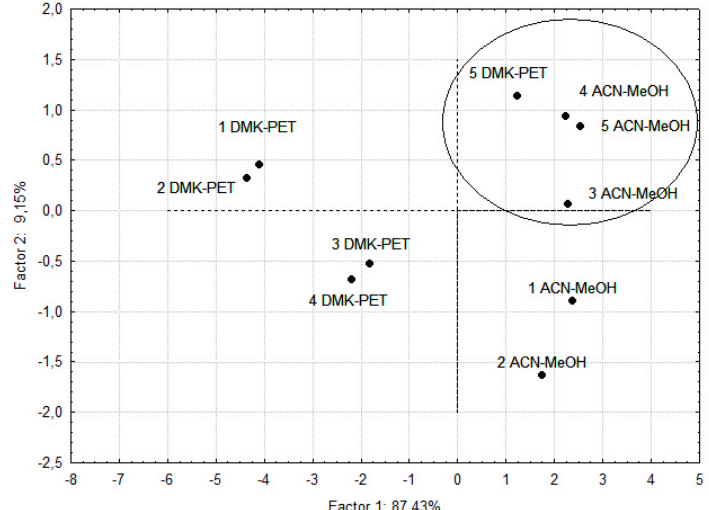
Figure 3. Principal component analysis 2 was performed with retention data (R ) of studied steroids using acetonitrile-methanol and acetone- M petroleum ether (10-90% v/v) as mobile phases and silica gel as a stationary phase. The numbers on the graph correspond to the hormone respectively: 1 – cortisone, 2 – hydrocortisone, 3 – methylprednisolone, 4 – prednisone and 5 – norgestrel. The matrix consists of 10 cases and 9